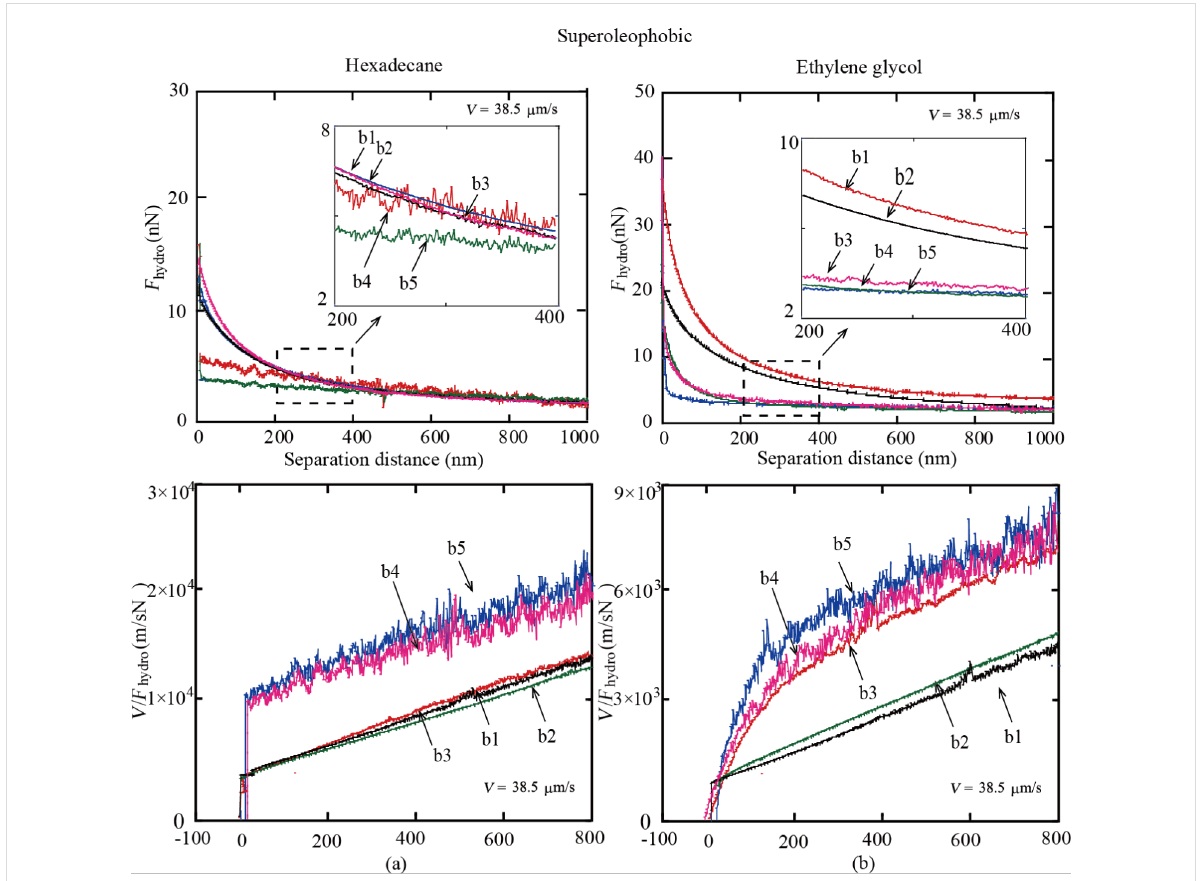
In conclusion, it was shown that the amplitude parameters of surface roughness could significantly inhibit the degree of boundary slip on the superoleophilic and superoleophobic sur- faces immersed in oil. For fluidic systems in which liquids and surface roughness were similar to that used in this study, it is suggested that boundary slip is likely enhanced and results in a corresponding reduction of the drag with decreasing